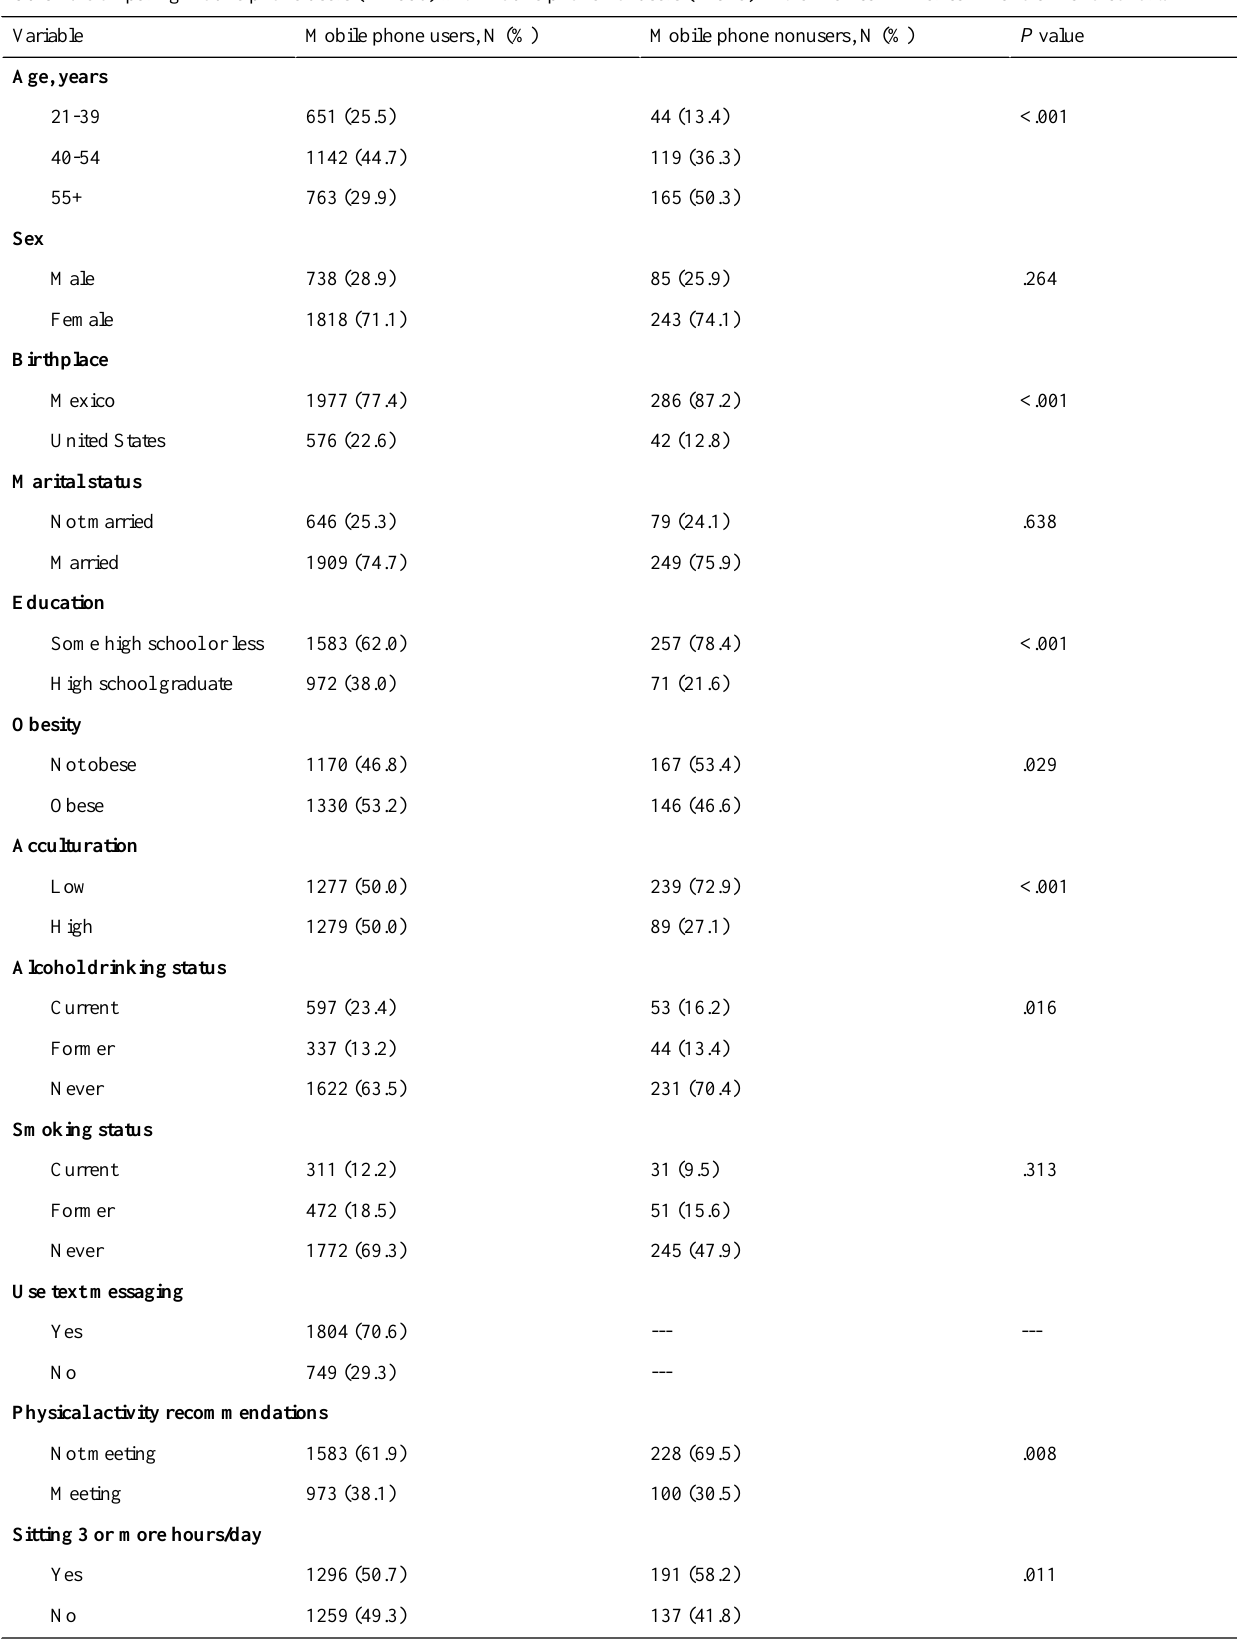
Table 1. Comparing mobile phone users (n=2556) with mobile phone nonusers (n=328) in the Mexican American Mano a Mano